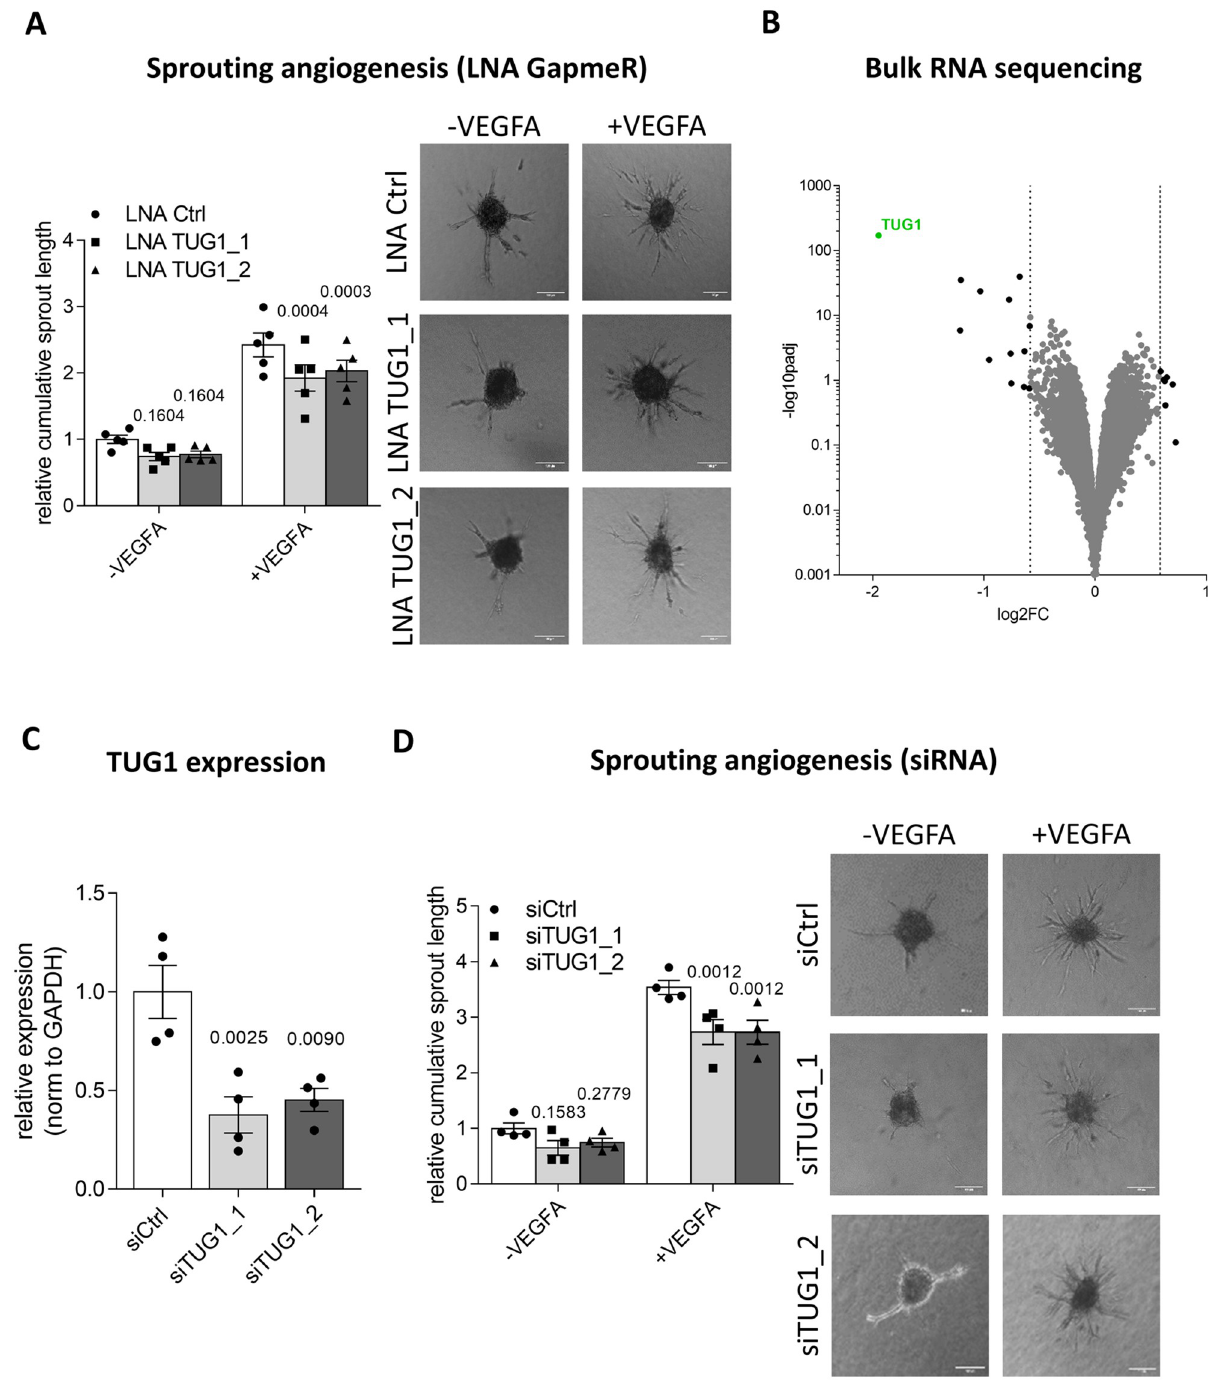
Fig 3. TUG1 influences VEGFA-stimulated sprouting. (A) Quantification of cumulative sprout length by in vitro spheroid-assay after LNA GapmeR- mediated TUG1 knockdown under basal conditions or with VEGFA stimulation (50 ng/ml for 24 h) in HUVECs. Representative images show the extent of sprouting as compared to 200 μ m size bar (n = 5; SEM; RM two-way ANOVA with Geisser-Greenhouse correction and Holm-Sidak multiple comparison test). (B) Volcano plot of deregulated genes (log2 fold change vs.–log10 adjusted p-value) based on HUVEC bulk RNA-sequencing data (LNA Ctrl vs. LNA TUG1; n = 3 vs. 3). TUG1 is represented by green dot. (C) TUG1 expression levels in HUVECs 48h after siRNA transfection using RT-qPCR. Expression is relative to GAPDH (n = 4; SEM; RM One-way ANOVA with Holm-Sidak correction). (D) Quantification of cumulative sprout length by in vitro spheroid-assay after siRNA-mediated TUG1 knockdown under basal conditions or with VEGFA stimulation (50 ng/ml for 24 h) in HUVECs. Representative images show the extent of sprouting as compared to 200 μ m size bar (n = 4; SEM; RM two-way ANOVA with Geisser- Greenhouse correction and Holm-Sidak multiple comparison